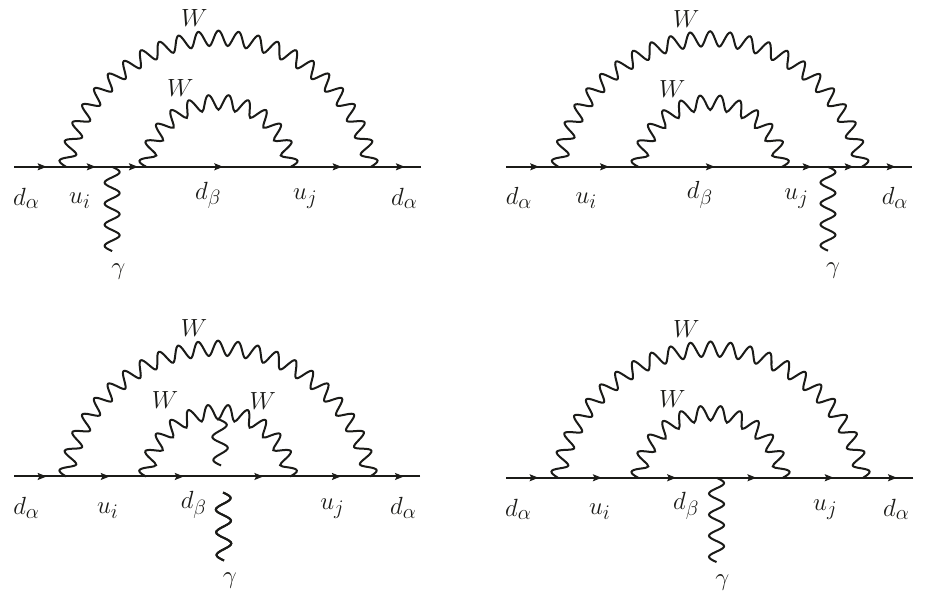
Figure 2 . Variations of diagrams that have a chance to induce non-zero EDM. We find the self- energy structure for u and u from the diagrams in the upper row. On the other hand, we find i j vertex correction from the diagrams in the lower